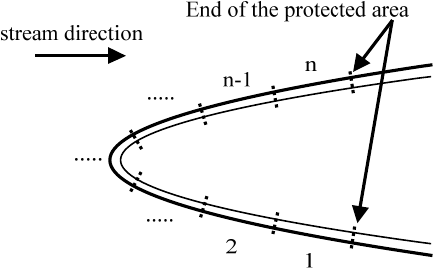
Figure 2. Division of heating zones within the protected area.